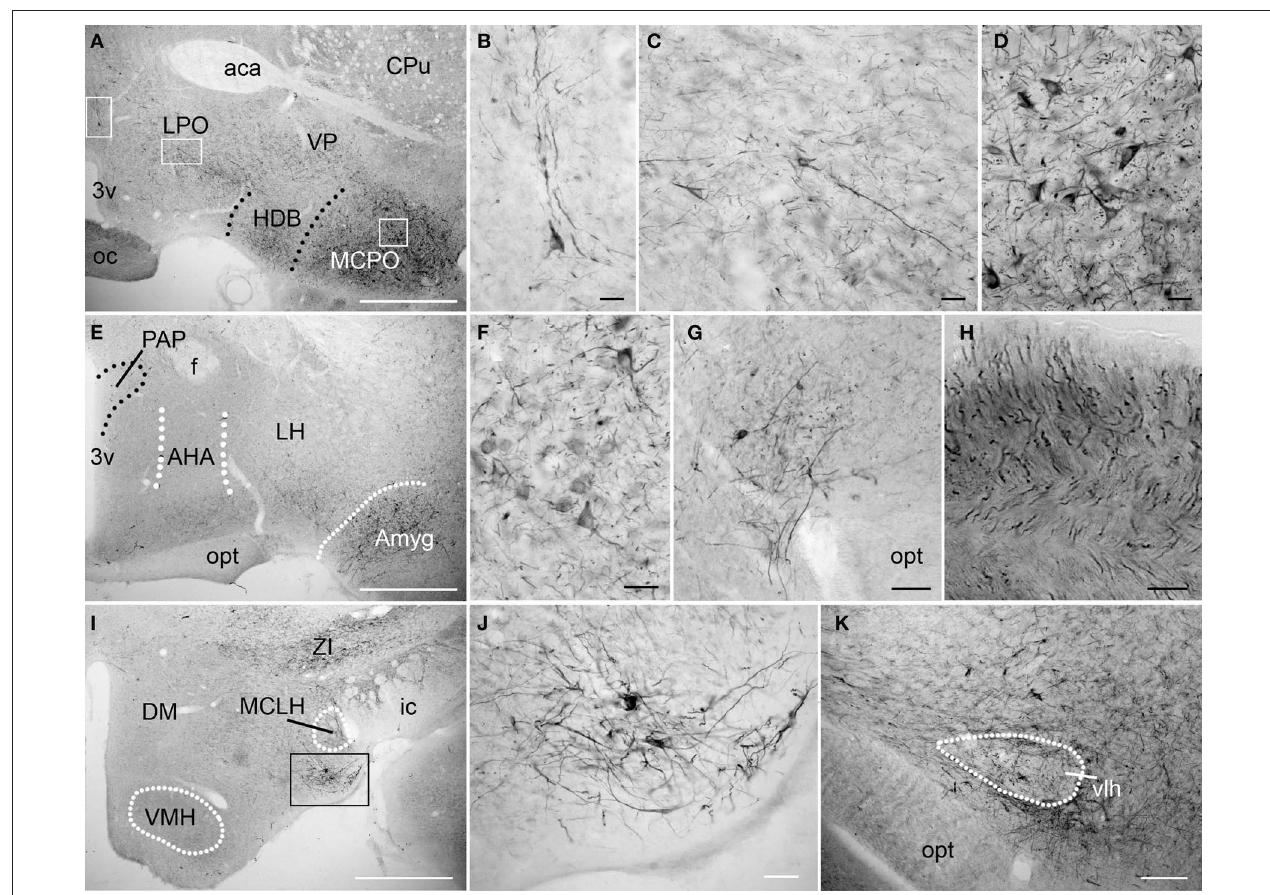
Figure 6 | PlexinA4 in the amygdala and the hypothalamus. Micrographs of the hypothalamic and amygdala region in coronal sections. In the anterior region of the hypothalamus (A–H) , PlexinA4 is found in scattered neurons and large caliber processes in the preoptic area (A,B) , the lateral preoptic area (LPO; A and C ) and in the magnocellular preoptic nucleus (MCPO; A and D ). Labeled axons are also visible in the optic chiasm (oc; H ). More posterior, PlexinA4 staining is present in neurons of the amygdala ( e and F ) and in a region immediately dorsolateral to the optic tract (opt; e and g ). No PlexinA4 was detected in the dorsomedial (DM) and ventromedial hypothalamus (VMH; i ) but strong labeling was seen in neurons and processes in a small nucleus medial to the internal capsule (ic) and ventral to the magnocellular nucleus of the lateral hypothalamus